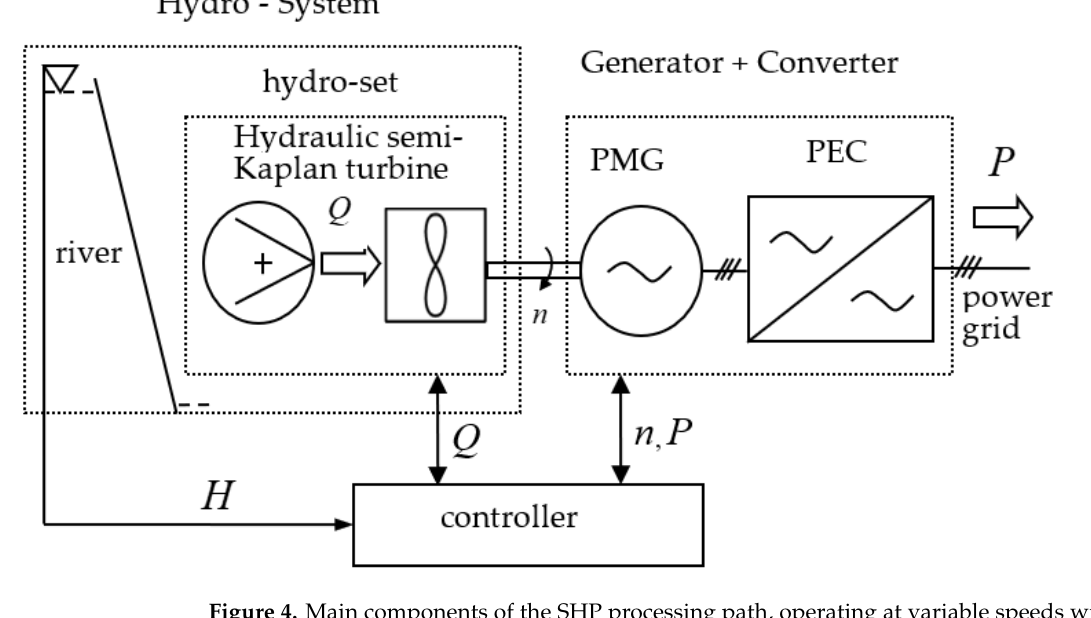
Figure 4. Main components of the SHP processing path, operating at variable speeds with a semi- Kaplan turbine.